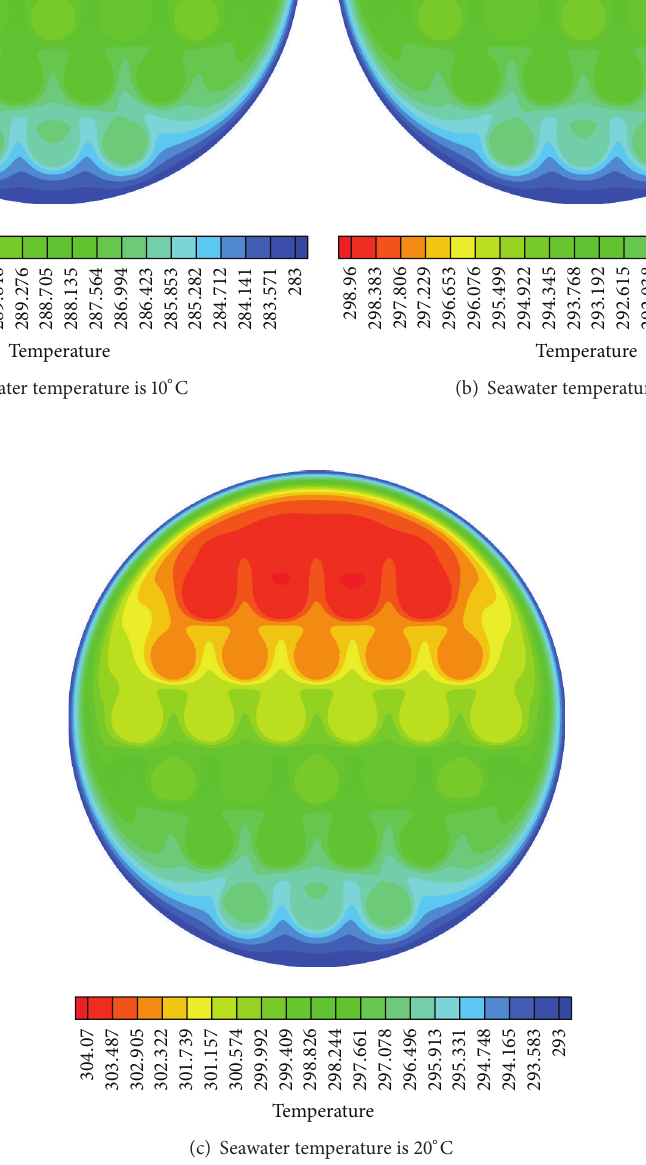
Figure 14: The battery compartment temperature distribution when the speed is